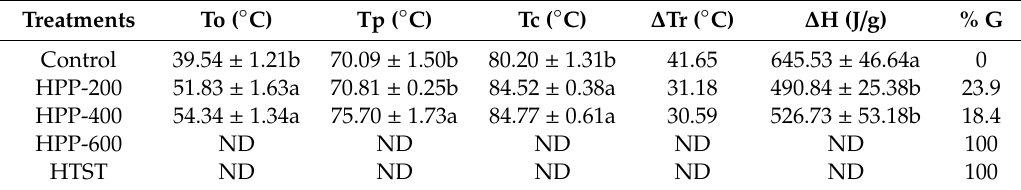
Table 2. Values of thermal properties by DSC analysis of pea starch processed by HPP in pigeon pea milk.